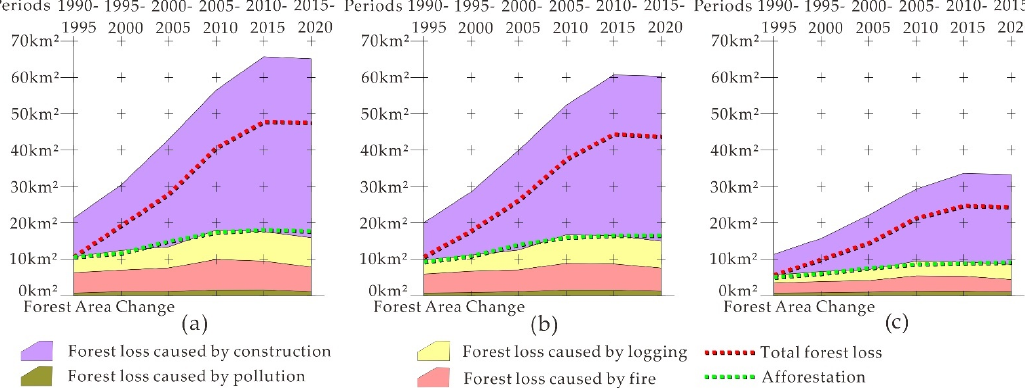
Figure 8. Forest loss curves of the metropolitan areas: ( a ) Changsha–Zhuzhou–Xiangtan metropolitan area; ( b ) Wuhan metropolitan area; ( c ) Nanchang metropolitan area.